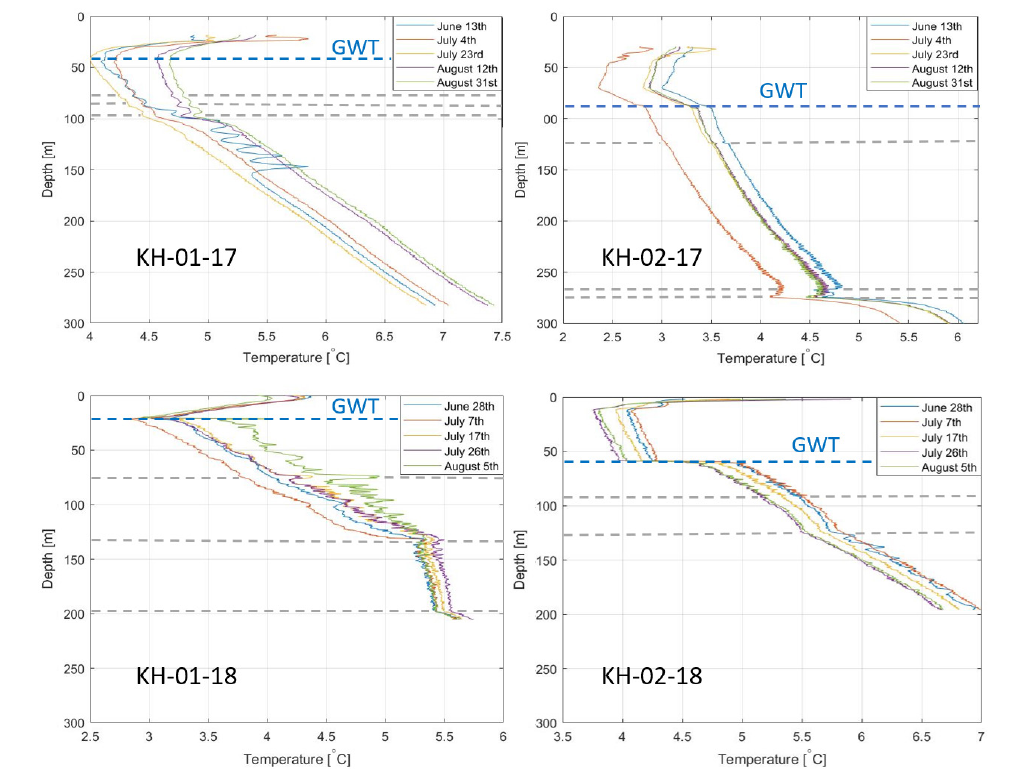
Figure 4. Temperature profiles in the four boreholes at various times during the measurement periods: Upper left: KH-01-17; Upper right: KH-02-17; Lower left: KH-01-18 and Lower right: KH-02-18. The groundwater table (GWT) and identified fractures are marked by stippled lines. For all boreholes except KH-01-17, the groundwater table causes a visible shift in temperature and/or temperature